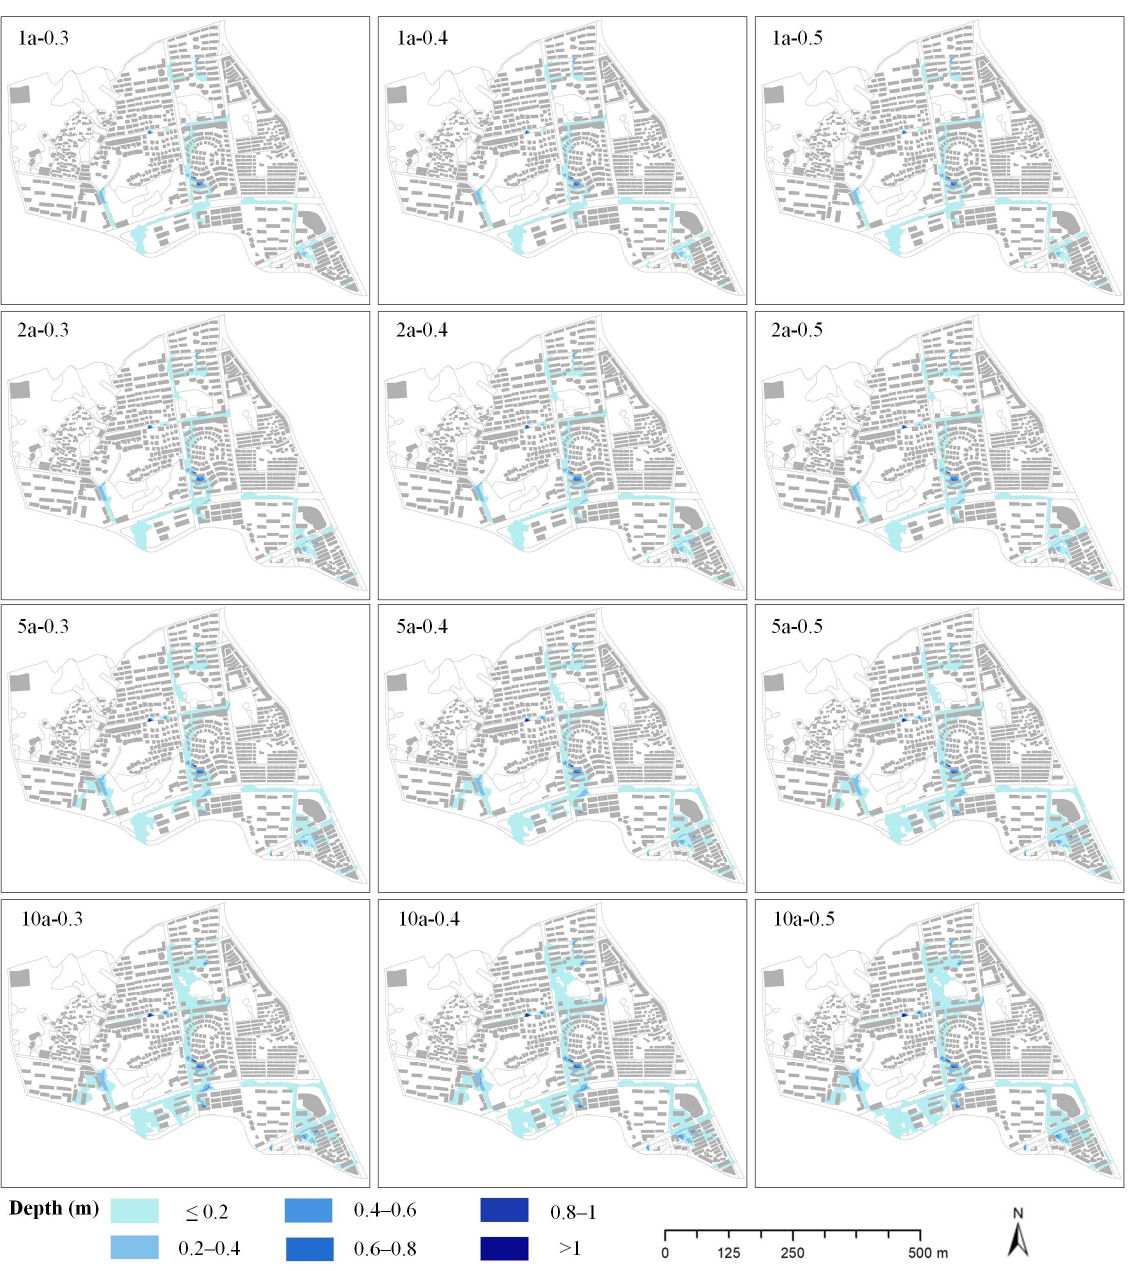
Figure 5. Simulation results under designed rainfall scenarios, where “1a-0.3” means P = 1a and r = 0.3 ( t = 120 min).